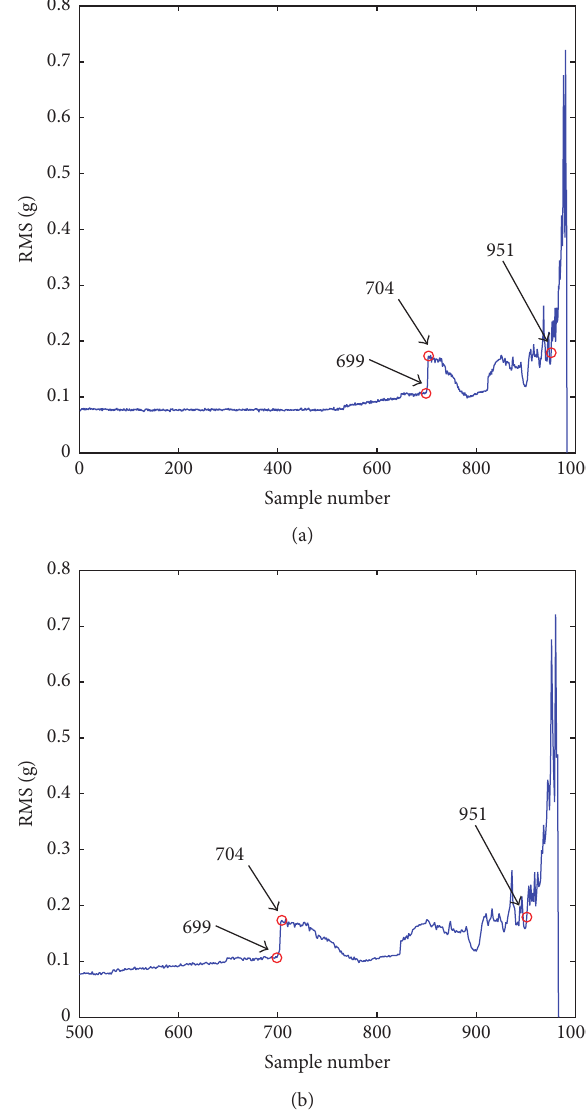
Figure 10: Root mean square (RMS). (a) Life-cycle RMS of bearing 1. (b) Local enlargement of